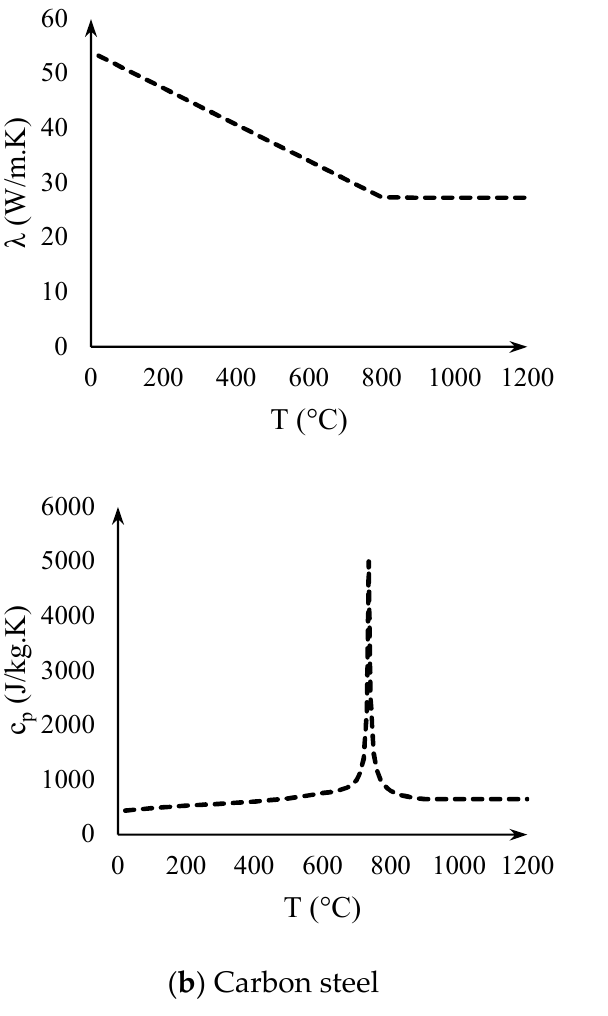
Figure 5. Variation of thermal properties of concrete and steel according to NF EN 1992-1-2 and EN 1993-1-2 [26].